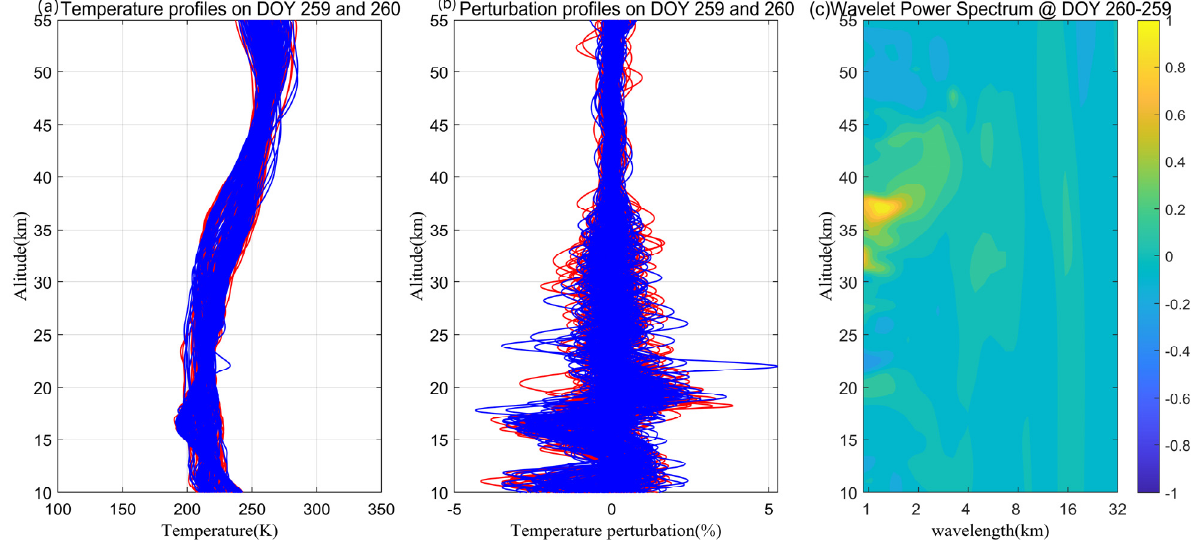
Figure 3. ( a ) Temperature profiles detected by the F3/C atmPrf datasets on DOY 259 (blue) and 260 (red) of 2015. ( b ) The corresponding temperature perturbation profiles. ( c ) The corresponding wavelet power spectrum differences between DOY 259 and 260 of 2015.